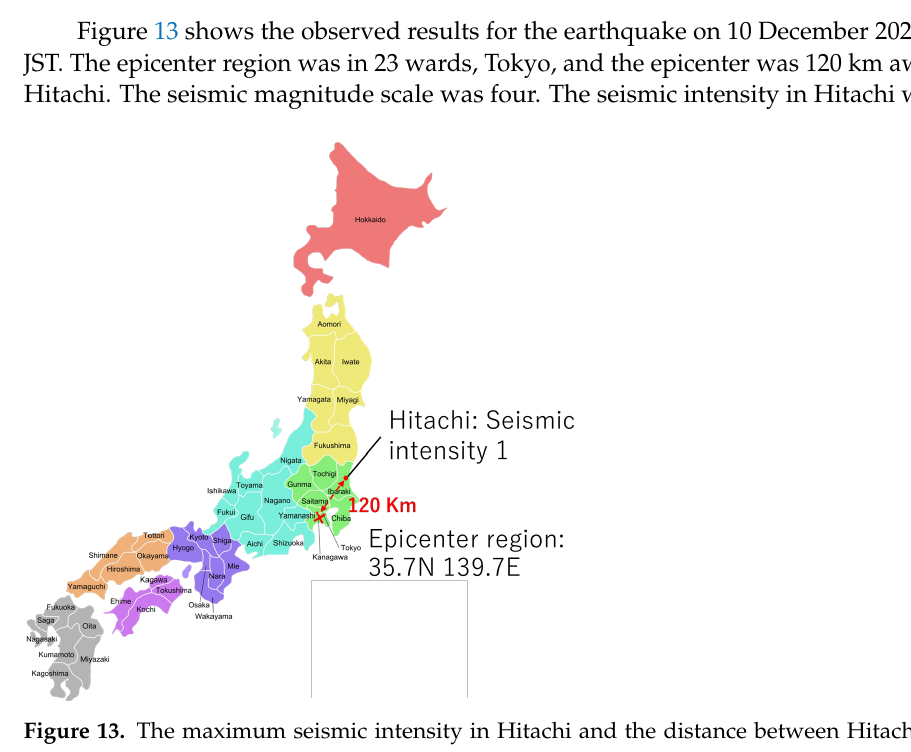
Figure 12. The number of reads per second of three RFID sensor tags at an earthquake seismic intensity of two. ( a ) The root sum square of the acceleration sensor system; the acceleration sensor system detected the earthquake at 10:17:05. ( b ) The number of reads per second of each RFID sensor tag in this experiment; the RFID sensor tags triggered the active mode at 10:16:50.